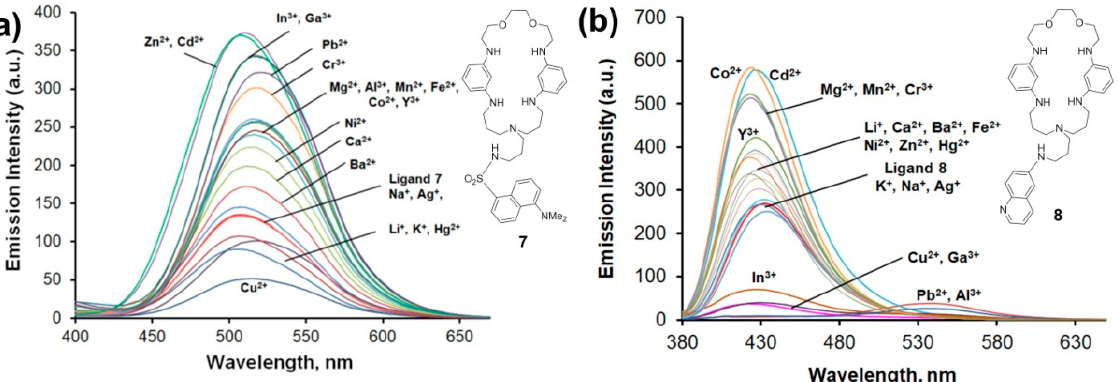
Figure 1. ( a ) Spectra of the fluorescence of compound 7 in the presence of Li(I), Na(I), K(I), Mg(II), Ca(II), Ba(II), Al(III), Cr(III), Mn(II), Fe(II), Co(II), Ni(II), Cu(II), Zn(II), Cd(II), Hg(II), Pb(II), Ag(I), Ga(III), In(III) and Y(III) (five equiv.). C L 48 µ M, λ ex 340 nm. ( b ) Spectra of the fluorescence of compound 8 in the presence of Li(I), Na(I), K(I), Mg(II), Ca(II), Ba(II), Al(III), Cr(III), Mn(II), Fe(II), Co(II), Ni(II), Cu(II), Zn(II), Cd(II), Hg(II), Pb(II), Ag(I), Ga(III), In(III) and Y(III) (five equiv.). C L 23 µ M, λ ex 365